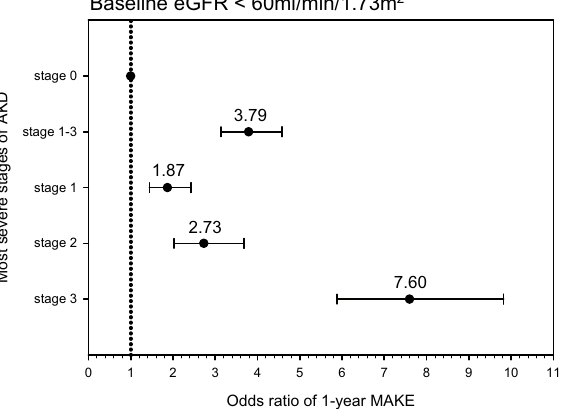
Figure 3. Adjusted odds of major adverse kidney event at 1-year follow-up in lower baseline eGFR group. Odds of major adverse kidney events stratified by most severe stage of AKD between 7–90 days after AKI, according to 16th Acute Disease Quality Initiative (ADQI) recommendations, in lower baseline eGFR group. Adjusted odds ratios (dots) and 95% CIs (lines) were calculated using logistic regression, where the reference category was patients who were AKD stage 0. Logistic regression was adjusted for age, sex, hypertension, heart disease, diabetes, anemia, cerebrovascular disease, cancer, COPD and digestive tract disease. Clinical significance was observed while comparing AKD stages 1–3 versus stage 0. AKD acute kidney disease, AKI acute kidney injury, eGFR estimated glomerular filtration rate, COPD chronic obstructive pulmonary disease.